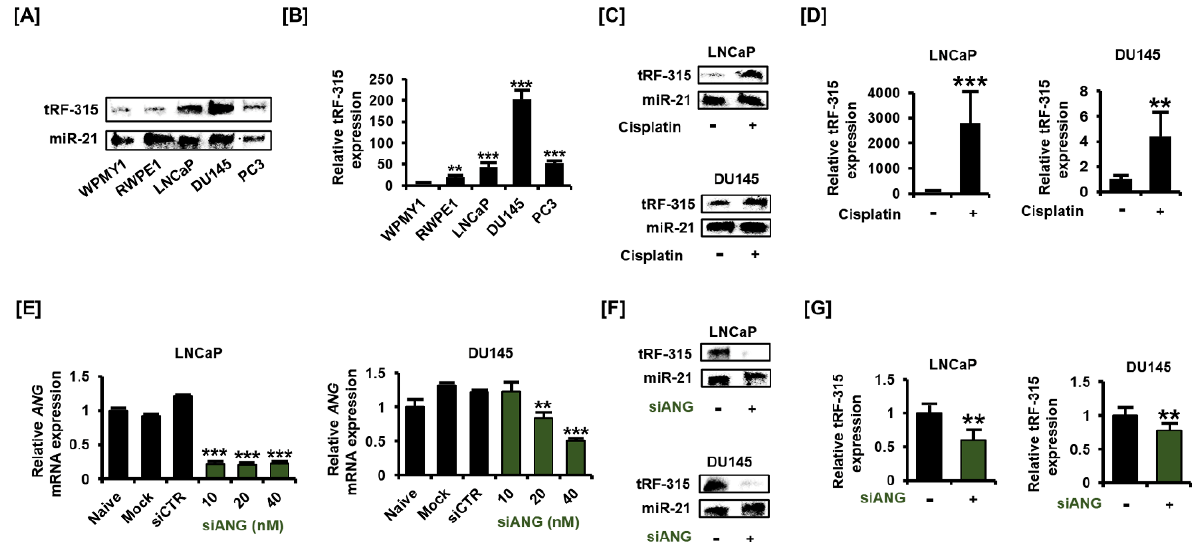
Figure 1. tRF-315 is abundantly expressed in prostate cancer cell lines. ( A ) The expression of tRF-315 in WPMY1, RWPE1, LNCaP, DU145, and PC3 cells was detected by blotting using DIG-labeled probe, splinted ligation, and EDC cross-linking. ( B ) Quantitative PCR was performed to quantify the expression of tRF-315 in WPMY1, RWPE1, LNCaP, DU145, and PC3 cells. ( C ) The expression of tRF-315 in response to cisplatin (20 µ M) treatment for 24 h in LNCaP and DU145 cells was detected by blotting. ( D ) Quantitative PCR was performed to quantify the expression of tRF-315 in response to cisplatin (20 µ M) treatment for 24 h in LNCaP and DU145 cells. ( E ) The mRNA expression of ANG in LNCaP and DU145 cells in response to siANG (10, 20, and 40 nM) for 6 h was measured via quantitative PCR. ( F ) The expression of tRF-315 in response to transfection of siANG (20 nM) for 6 h in LNCaP and DU145 cells was detected by blotting. ( G ) Quantitative PCR was performed to quantify the expression of tRF-315 in response to the transfection of siANG (20 nM) for 6 h in LNCaP and DU145 cells. The expression of tRF-315 was quantified using the 2 − ∆∆ CT method based on standard curves and cycle threshold (C T ) values. The data represent three independent experiments. The asterisks indicate significant differences between treated cells and control cells (*** p < 0.001 and ** p < 0.01).